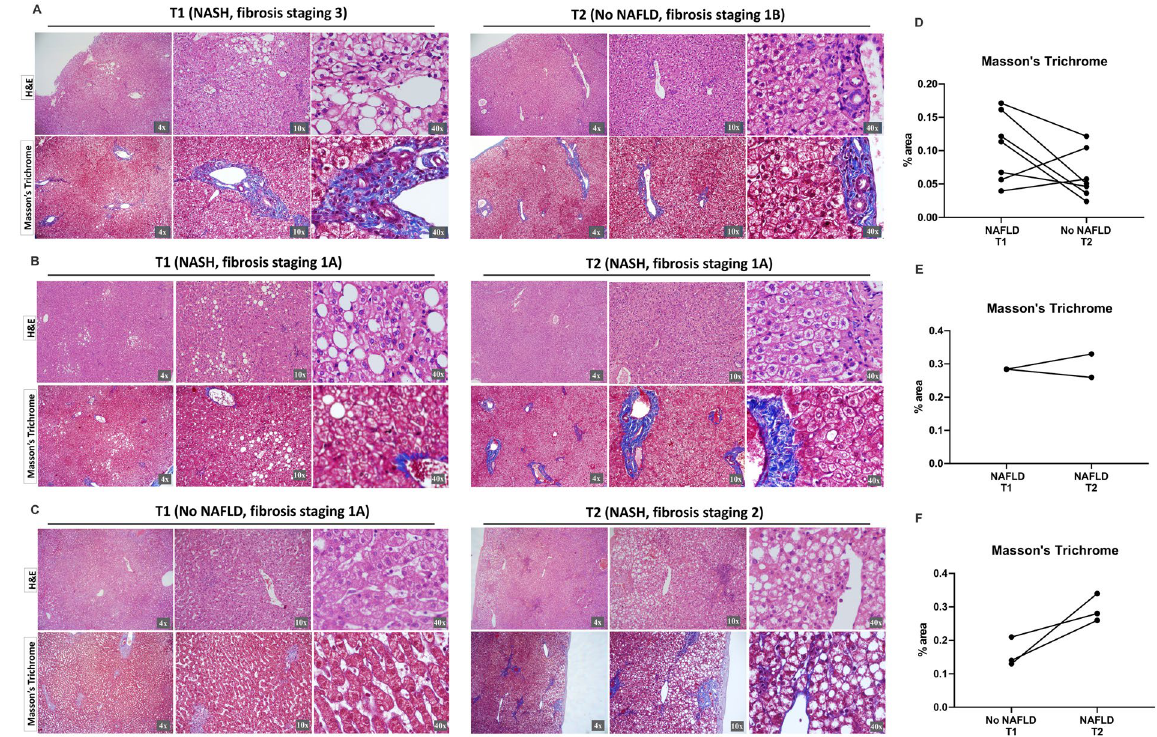
Figure 5. Histopathological analysis of liver biopsies at the time (T1) and after (T2) bariatric surgery showed NAFLD regression after the procedure. A-C. Representative images of hematoxylin and eosin (H&E) and Masson’s Trichrome staining of the T1 and T2 groups. Collagen fibers stained by the Masson’s Trichrome are shown in blue. (A) NAFLD regression ( * p = 0.0152, n = 7). (B) NAFLD maintainance (n = 2). (C) Development of liver disease after bariatric surgery (n = 3). 4 × , 10 × and 40 × objective lenses were used as indicated in each image. (D–F) Quantitative analysis of Masson’s Trichrome staining in T1 and T2 of patients who presented NAFLD in T1 and/or T2.